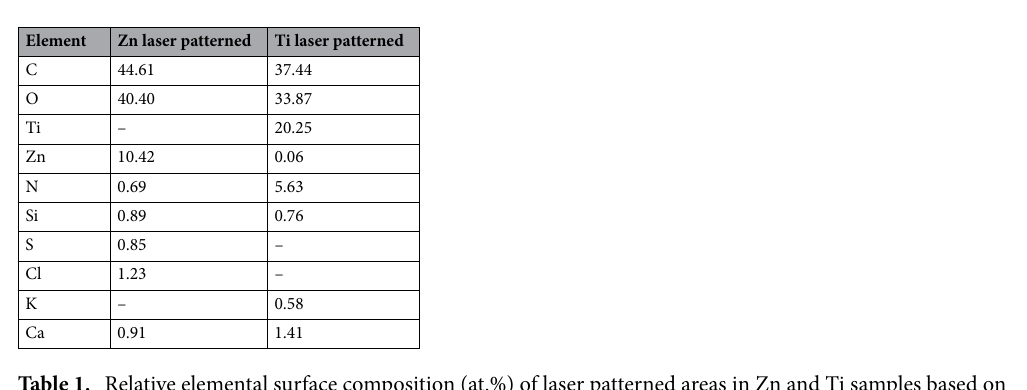
Table 1. Relative elemental surface composition (at.%) of laser patterned areas in Zn and Ti samples based on XPS.